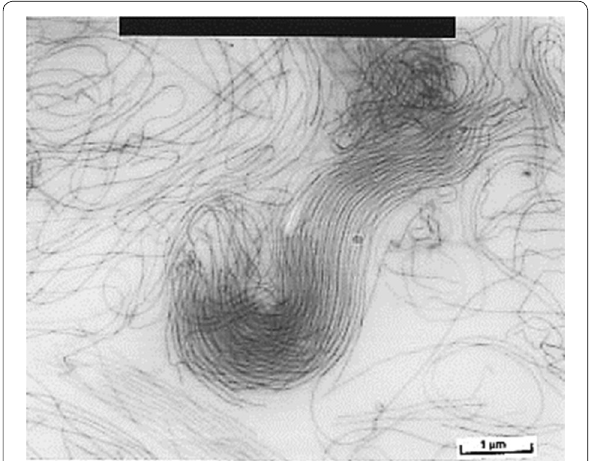
Fig. 13 TEM image of diblock nanofibers